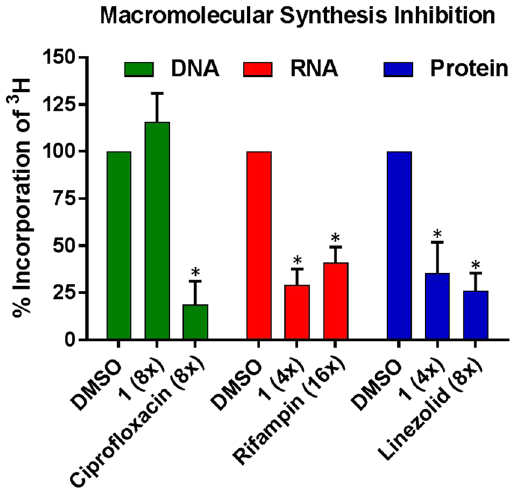
Figure 4. Results of HP 1 against MRSA BAA-1707 in macromolecular synthesis inhibition experiments with [ 3 H]-labeled precursors (generated from three, or more, independent experiments). HP 1 inhibits RNA and protein biosynthesis while not inhibiting DNA biosynthesis (p-values ≤ 0.005 * ; pairwise student t-test comparing relative treated samples to DMSO vehicle only